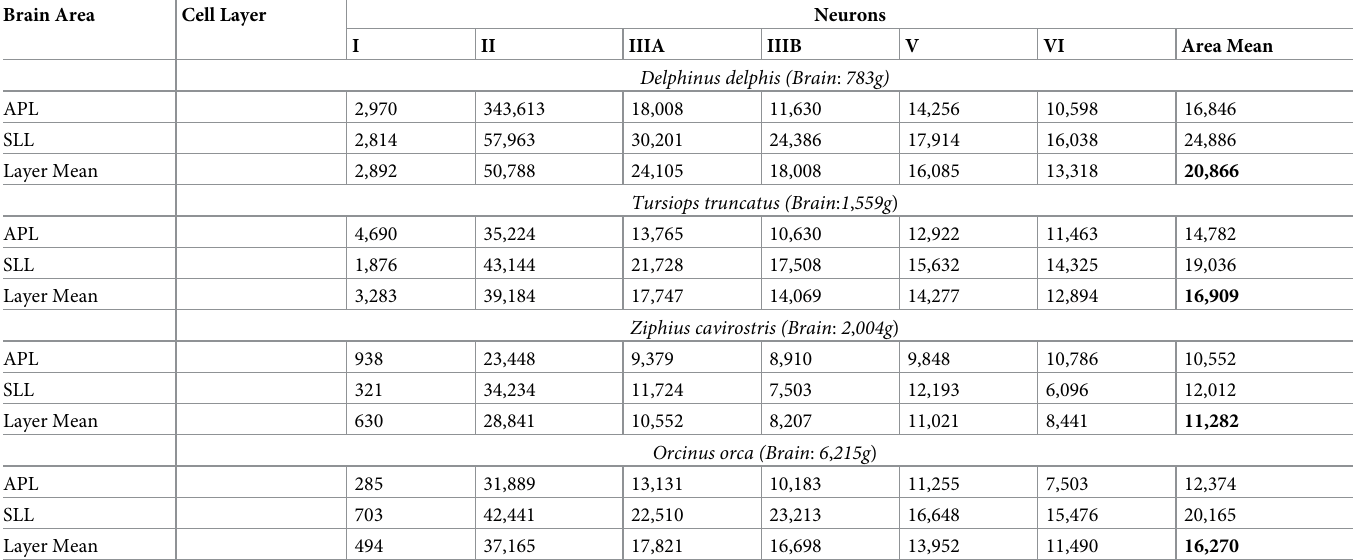
Neuron cell packing density ranges for four species of odontocetes by cell layer and brain area. APL = anterior paralimbic lobule; SLL = supralimbic lobule. All values represent average neuron